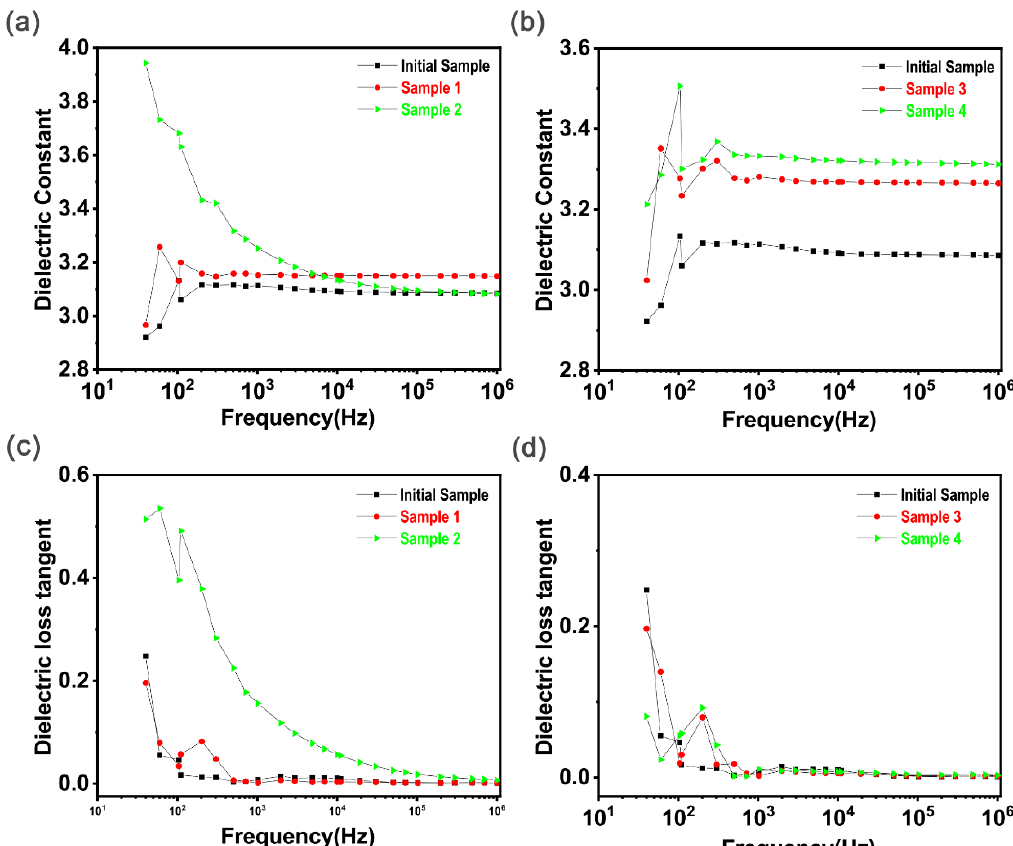
Figure 9. ( a , c ) The dielectric constant and dielectric loss test for the original sample and samples 1 and 2 at different frequencies. ( b , d ) The dielectric constant and dielectric loss test for the original sample and samples 3 and 4 at different frequencies.